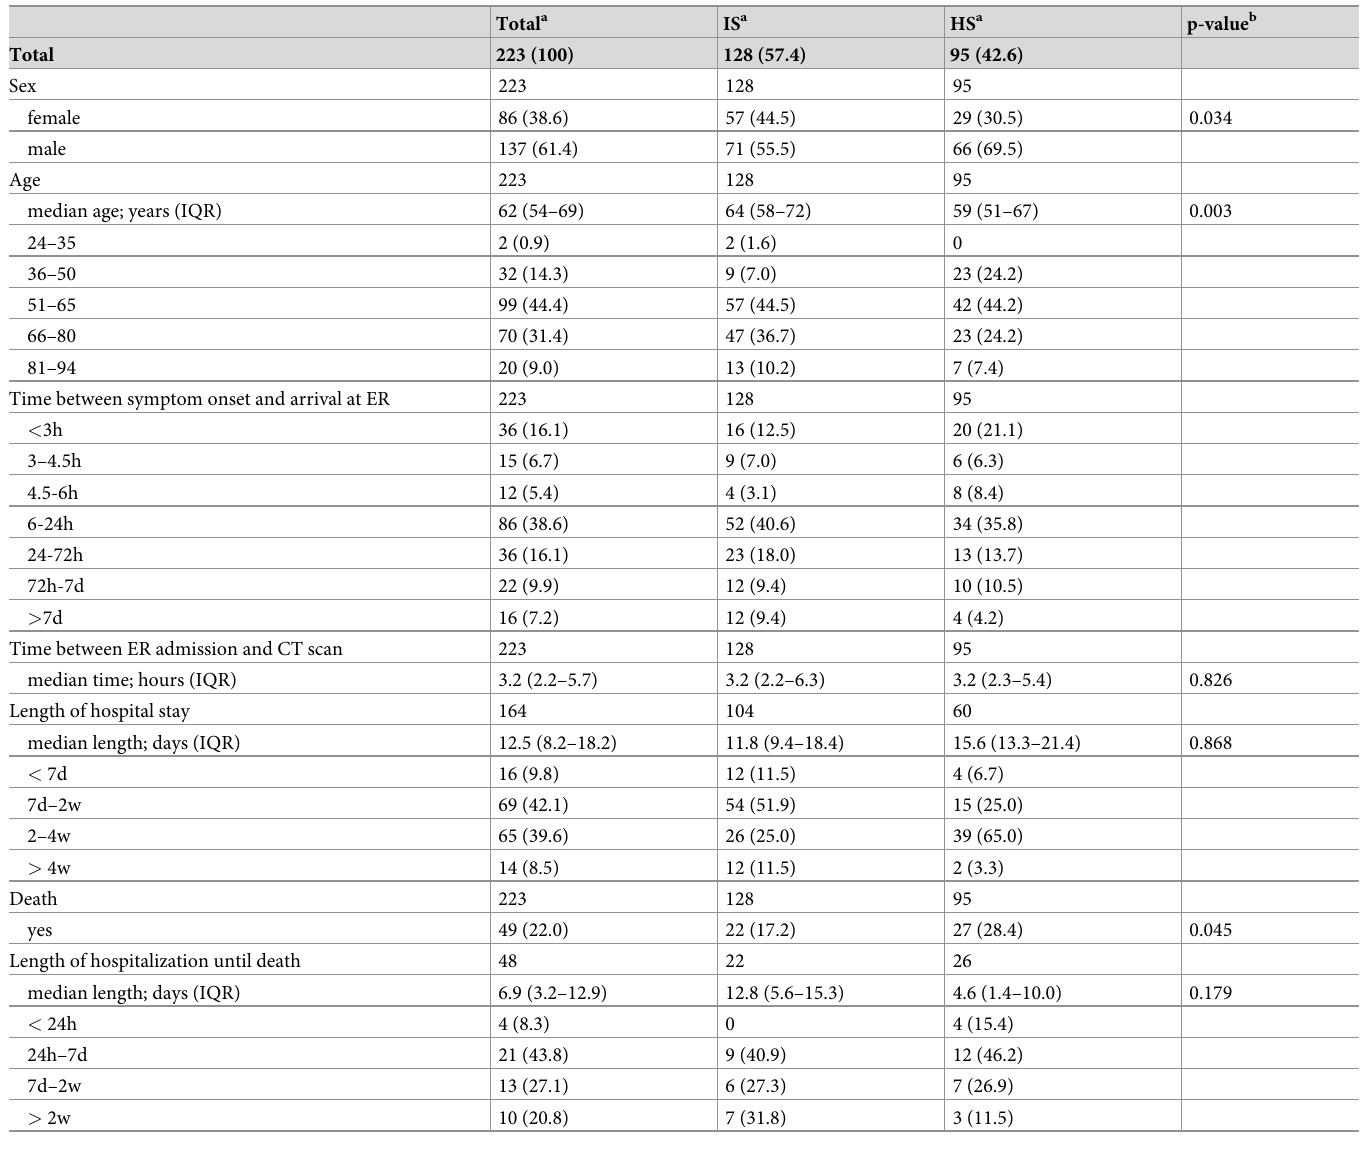
Table 1. Demographic and clinical characteristics by stroke